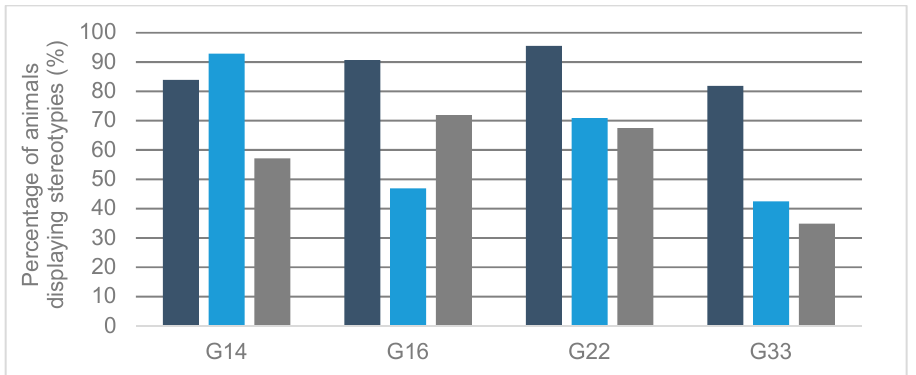
Figure 1. Percentage of animals observed displaying different stereotypic behavioral patterns in different housing systems. G14 = groups of 14 animals, G16 = groups of 16 animals, G22 = groups of 22 animals, G33 = groups of 33 animals. Dark blue = tongue playing, light blue = manipulating objects, gray = manipulating conspecifics.